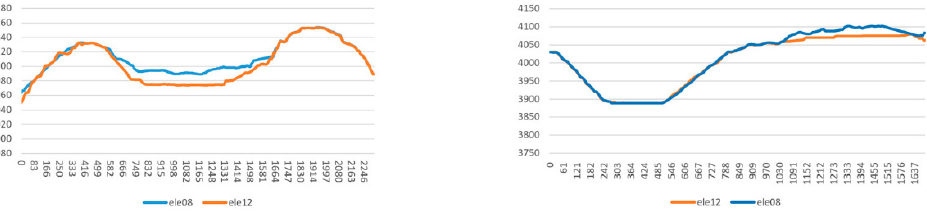
Figure 3. DSM and profile of Pit 4 in August 2020 and December 2020.